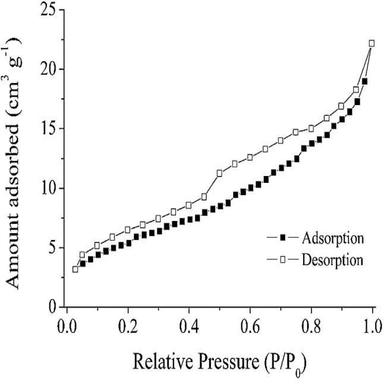
N2 adsorption-desorption isotherm for GO-MnFe2O4/VAC.